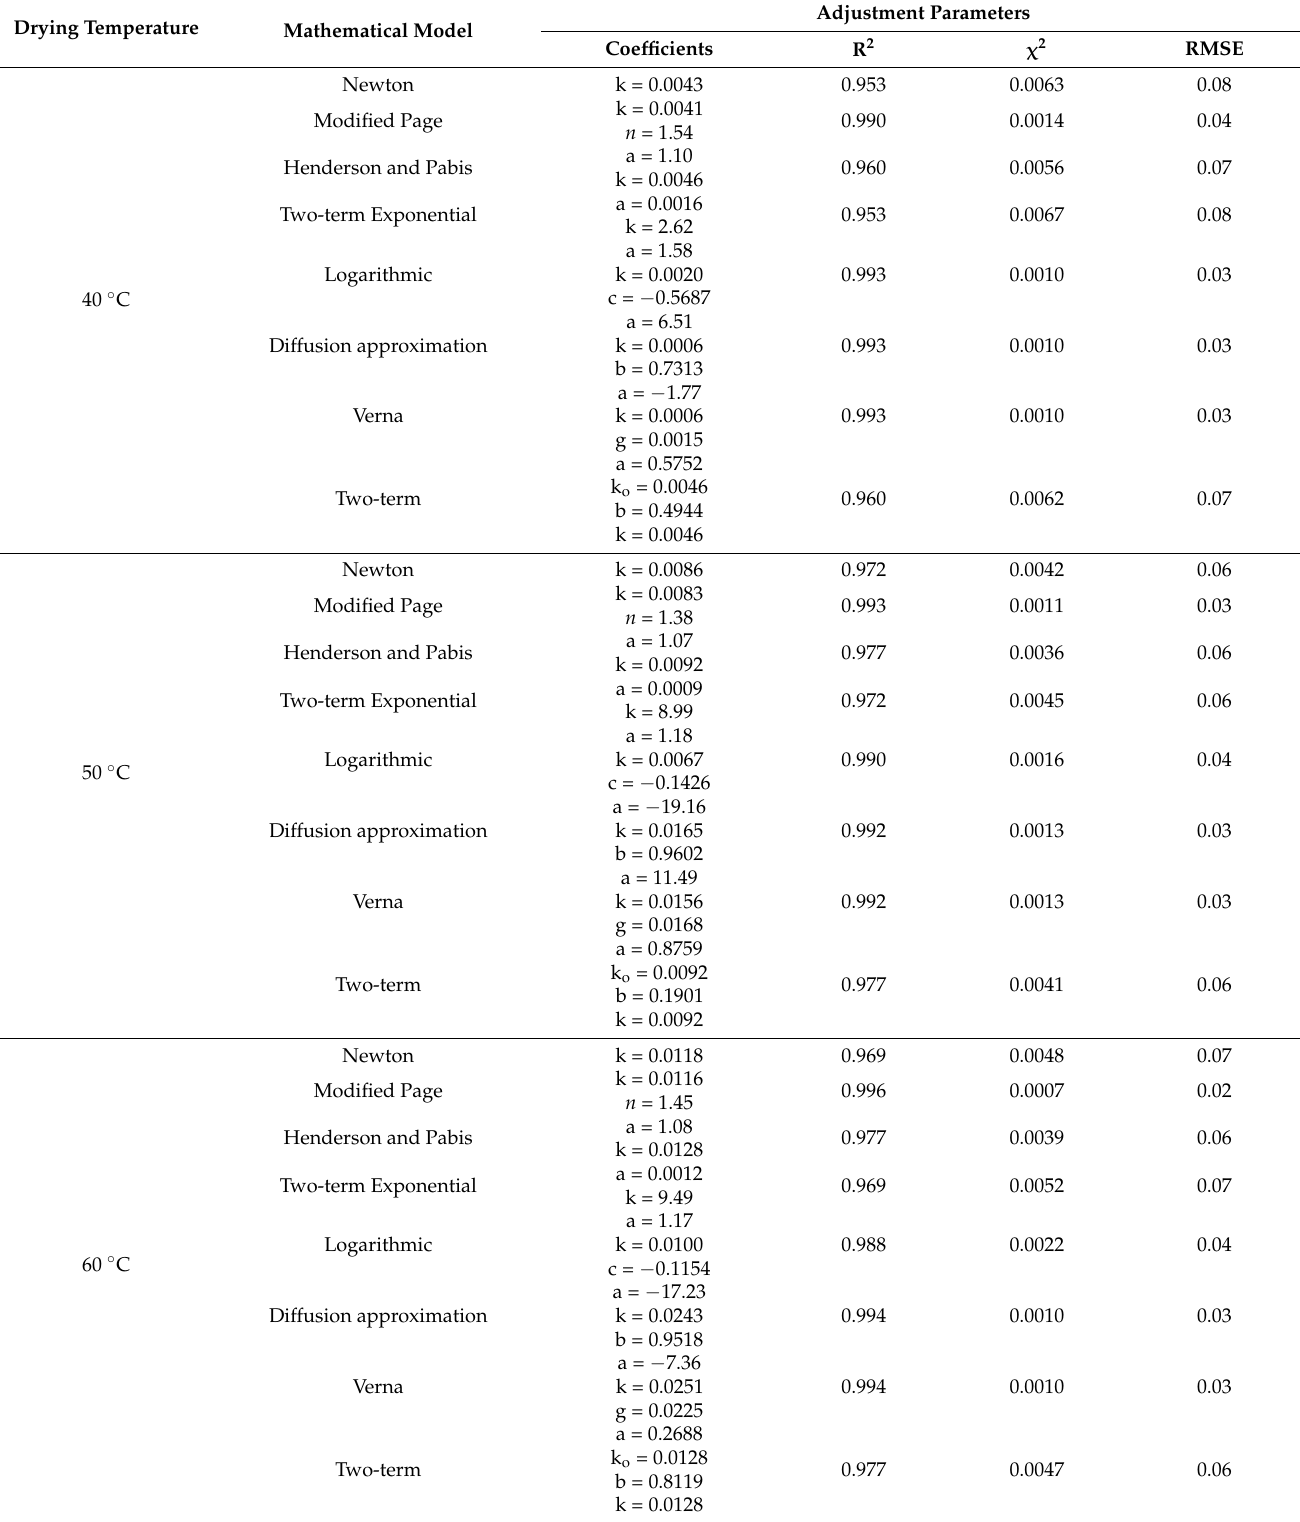
Table 2. Statistics modeling and parameters of the mathematical models adjusted to the drying data of the purple basil